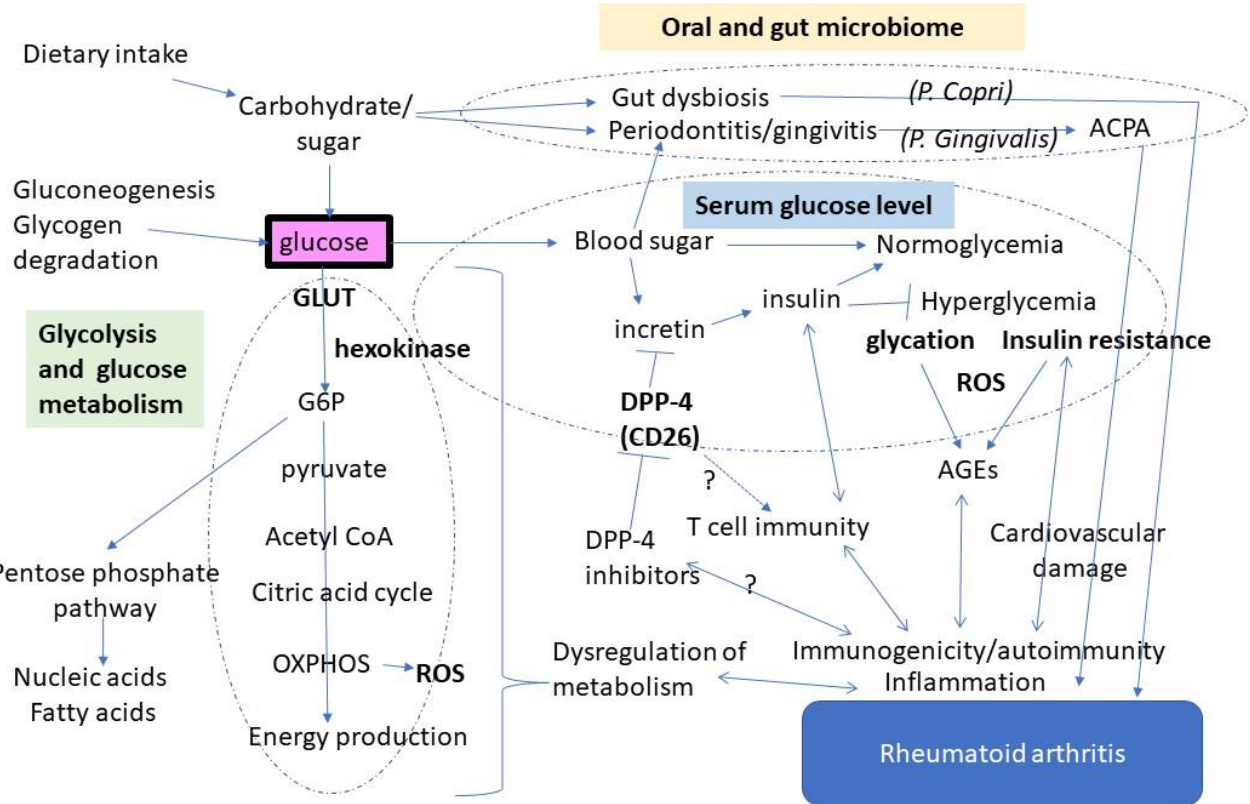
Figure 1. The schematic glucose demonstration as a center of the pathophysiology of rheumatoid arthritis. Glucose may play a role in the pathophysiology of autoimmunity and rheumatoid arthritis via its metabolic altera-tion, dysregulation of glucose levels, and influence in the inflammation in the oral cavity. G6P: Glycose-6-phosphate, OXPHOS: oxidative phosphorylation, P. copri: Prevotella copri, P. gingivalis: Porphyromonas gingivalis, DPP-4: dipeptidyl peptidase-4, AGEs: advanced glycation end-products, ACPA: anticitrullinated protein antibodies.